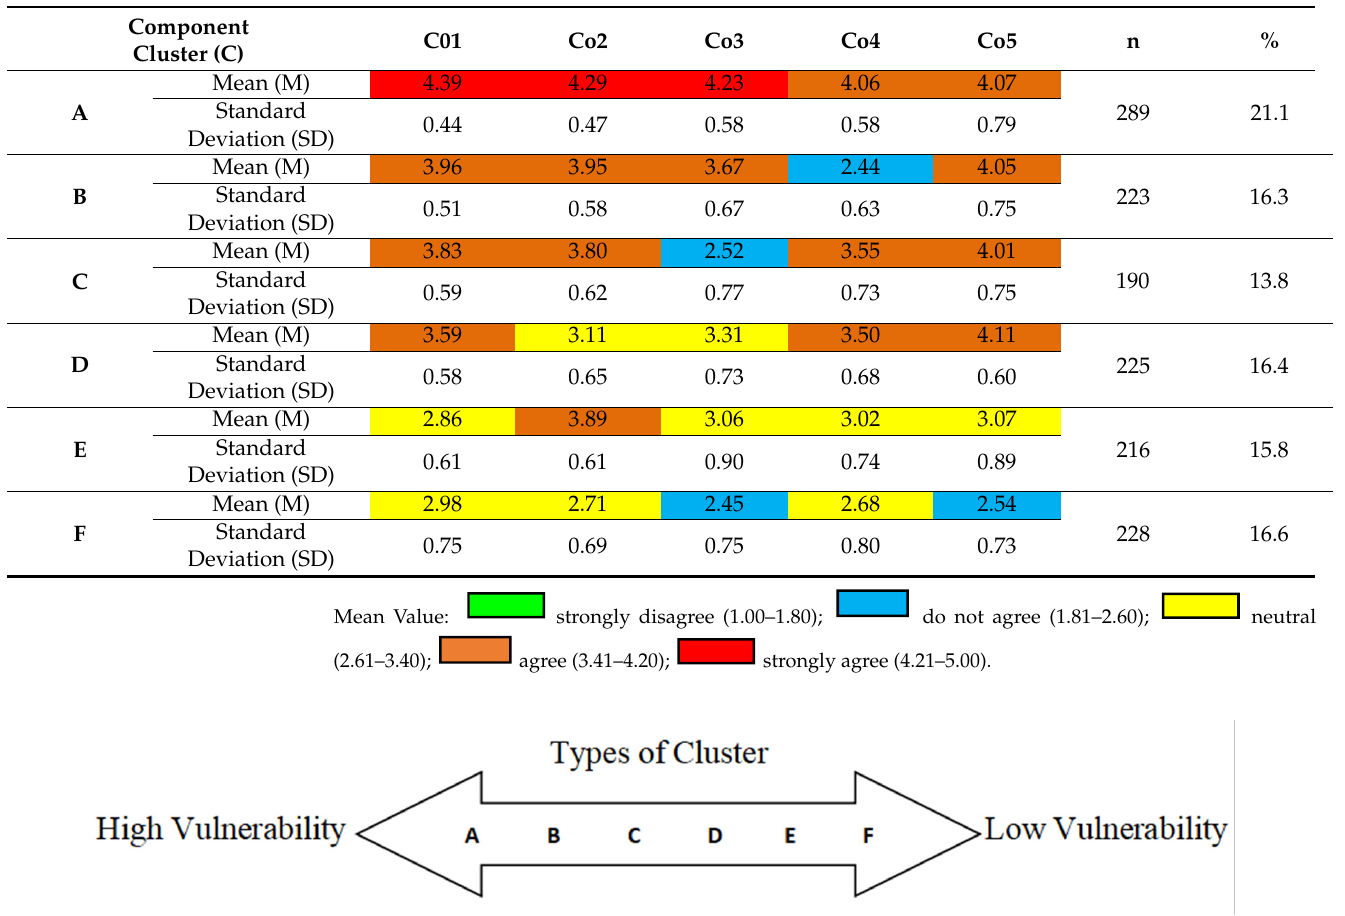
Table 4. Challenges of virtual learning based on clusters.